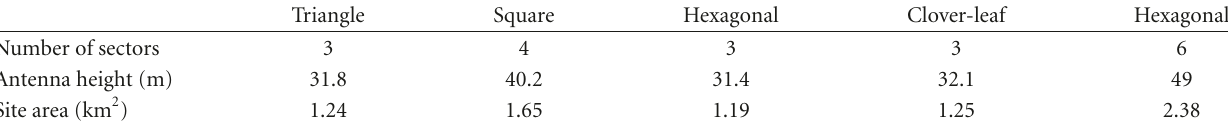
Table 7: Maximum site areas of 3-4 sector layouts.